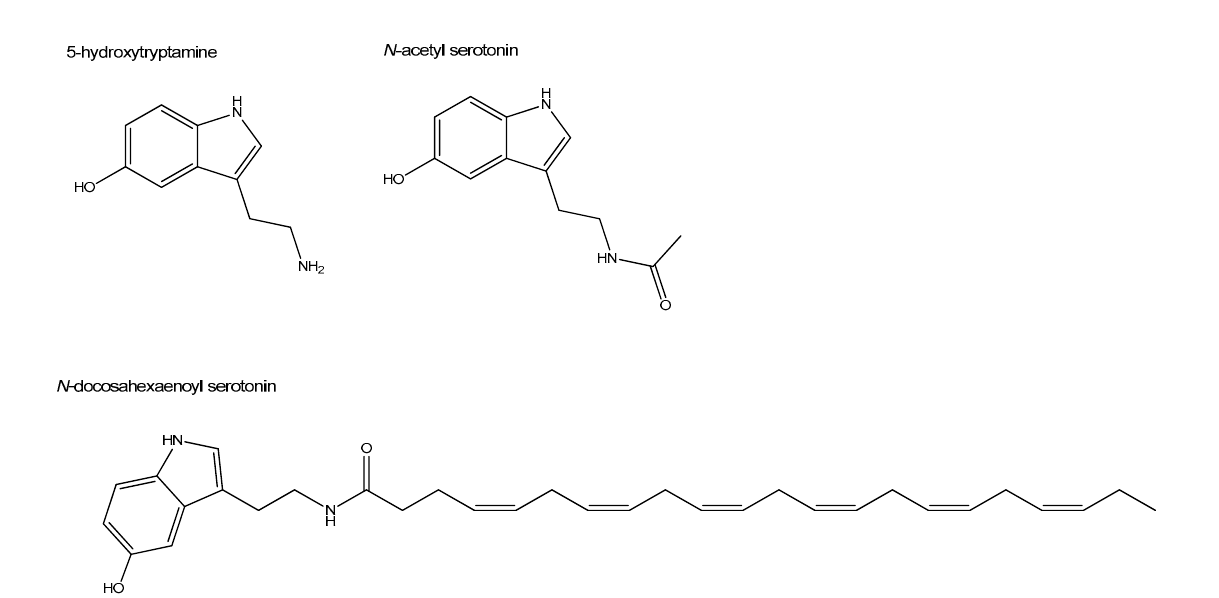
Figure 2. Chemical structures of serotonin (5-HT; 5-hydroxytryptamine) and its anti-inflammatory conjugates N -acetyl serotonin (NAS) and docosahexaenoyl serotonin (DHA-5-HT).